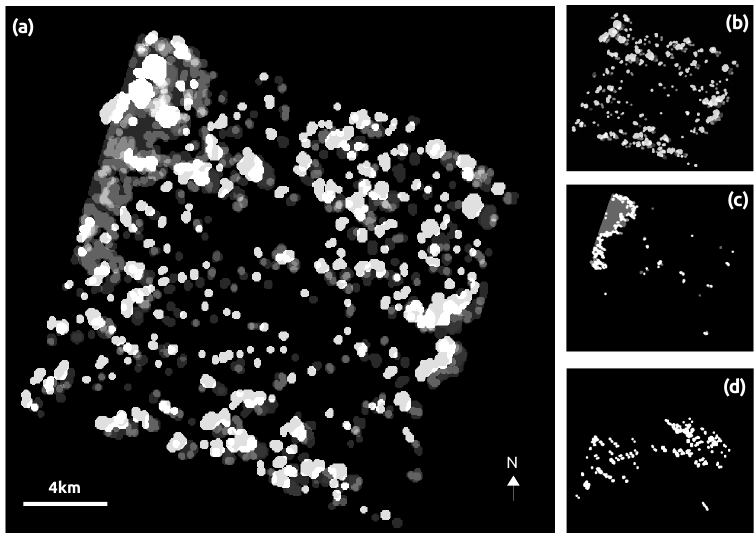
Figure 5. Resulting graylevel image of clouds and cloud shadows combining all the individual masks of the SITS at each date ( a ); or detected only in 26 May ( b ); in 20 July ( c ); and in 21 September ( d ). The grayscale intensity vary from black (cloud and shadow free) to white (maximum of clouds and